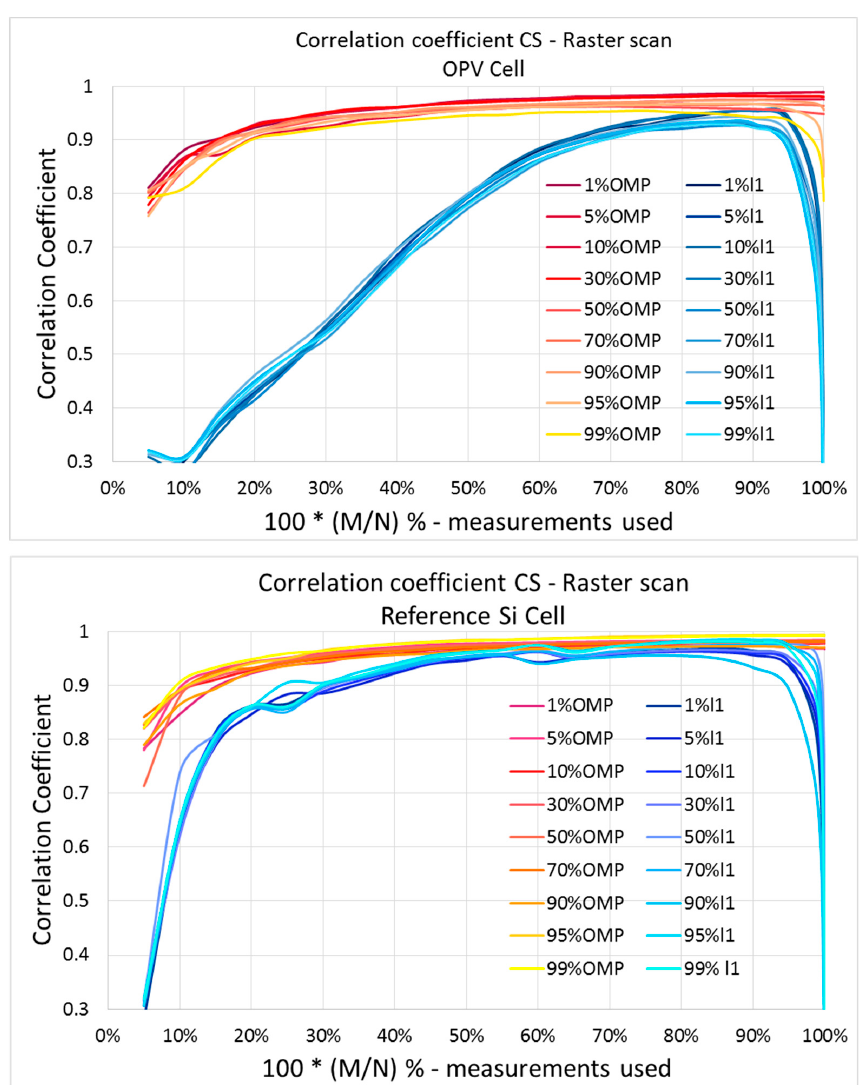
Figure 10. Correlation coefficient as a function of the number of measurements used for reconstruction, for sensing matrices with different sparsity levels, and for the two different algorithms. On the left, the graph for the c-Si reference cell; on the right, the results of the OPV cell. When approaching 100% of measurements used for reconstruction, the performance of the algorithms, especially that of the ℓ 1 algorithm, declines. This is because when measurement noise is included, the optimisation algorithm fails to find a solution for 100% of measurements used, as has been previously demonstrated in [22]. This is because the optimisation algorithm is increasingly constrained as we reach 100%, and has fewer degrees of freedom to filter out noise. There are algorithms available in the literature that can expect some noise in the measurements, and would not have such issues when approaching 100%. For the graphs in Figure 10, reconstruction was implemented for 99.0% as well as 99.9% of sampling, in order to accurately draw these curves. In reality, this area of undersampling is meaningless for compressive sampling, and such problems will not arise in real applications. 4. Conclusions